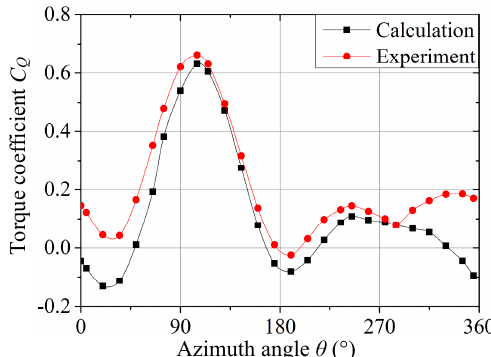
Figure 11. Torque coefficients acting on the single blade obtained from CFD simulations and wind tunnel experiments at pitch angle of β = 6°.